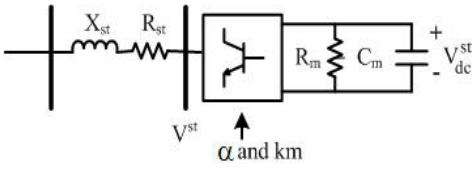
Figure 3. Model of static synchronous compensator